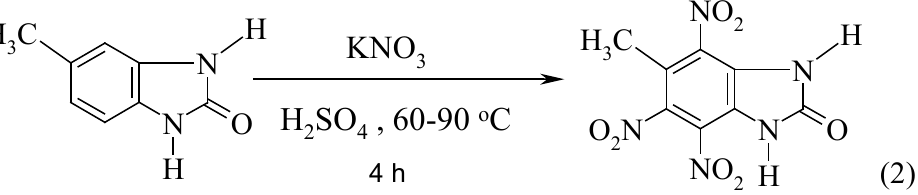
preparation of 5-methyl-TriNBO ( 2 ) in one